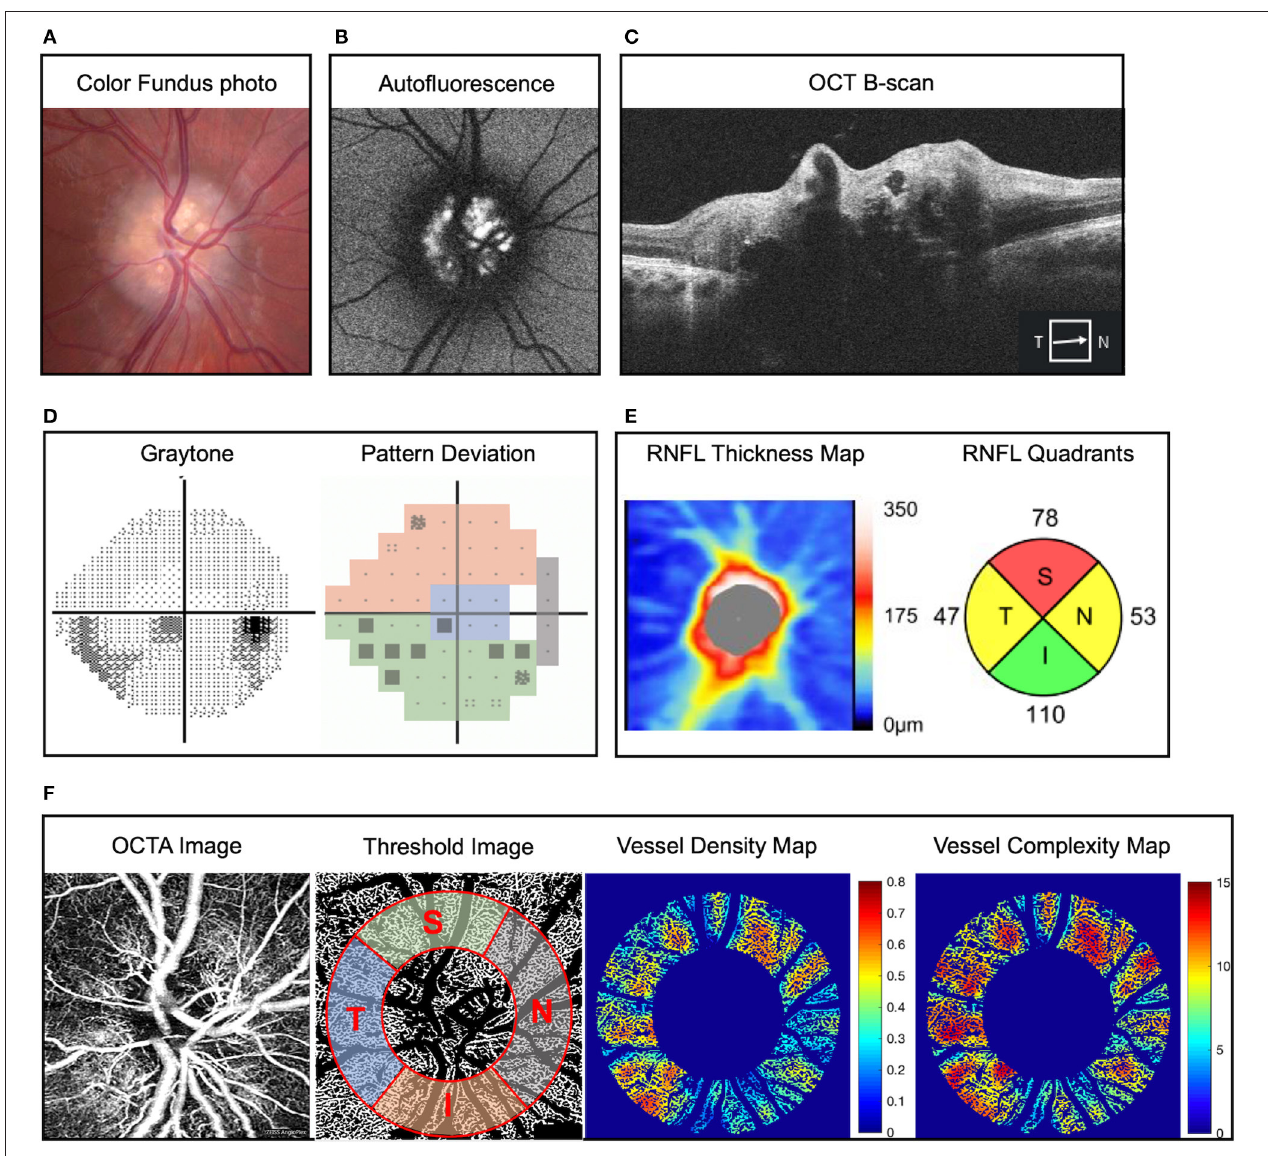
FIGURE 1 | Representative example of optic disc drusen (ODD) and right eye mild inferior visual field defect in a 22-year-old man. (A) Color fundus imaging showing full optic disc with refractile depositions in the optic disc and slightly blurred margin (right eye). (B) Autofluorescence imaging showing hyperautofluorescence of the optic disc typical of ODD. (C) Optic coherence tomography (OCT) B-scan reveals characteristic signal poor core with bright margins typical of ODD. (D) Static perimetry reveals inferior visual field defect in the right eye, and pattern deviation map demonstrates the modified Garway-Heath map of visual field. (E) Retinal nerve fiber layer (RNFL) thickness map on OCT showing superotemporal and nasal RNFL defect in the right eye. (F) Superficial capillary plexus of optic disc OCT angiography (OCTA) ( from left to right ) original image, threshold image with large vessel removal, annulus region of interest, and demarcation of the four quadrants according to the modified Garway-Heath map for visual field representation, vessel density heat map, and vessel complexity heat map. Vessel area density and vessel complexity index are calculated and represent area occupied by vessel divided by total area and branching complexity of the perfused vasculature, respectively (27). For ease of comparison, these values are shown on a linear color scale (heat map) from blue to red, which represents low to high vessel densities or low to high vessel complexities. VAD heat map scale is 0 to 0.8, and VCI heat map scale is 0 to 15. OCT, optical coherence tomography; OCTA, optical coherence tomography angiography; RNFL, retinal nerve fiber